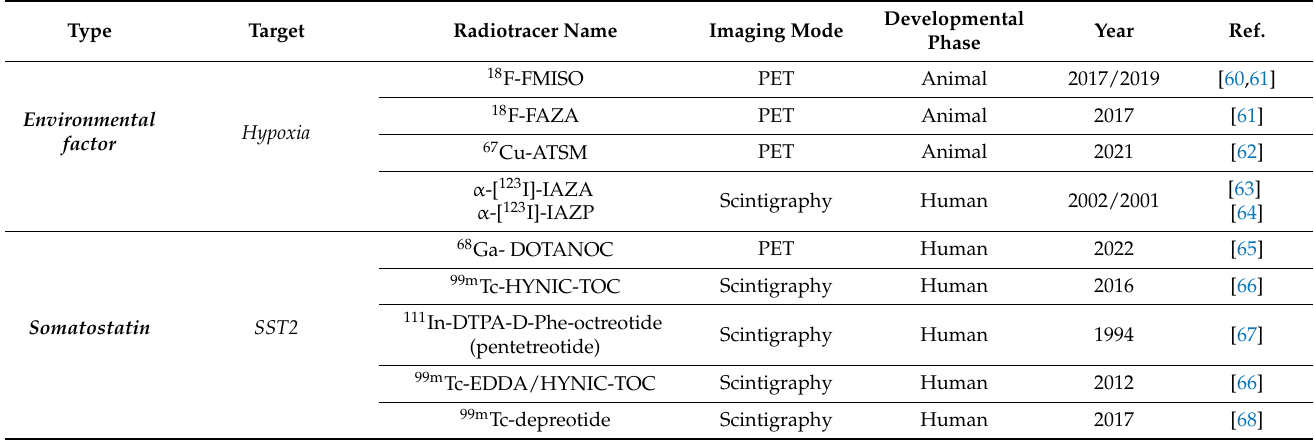
Table 1. Overview of all of the investigated PET/SPECT and scintigraphy tracers targeting angiogen- esis in